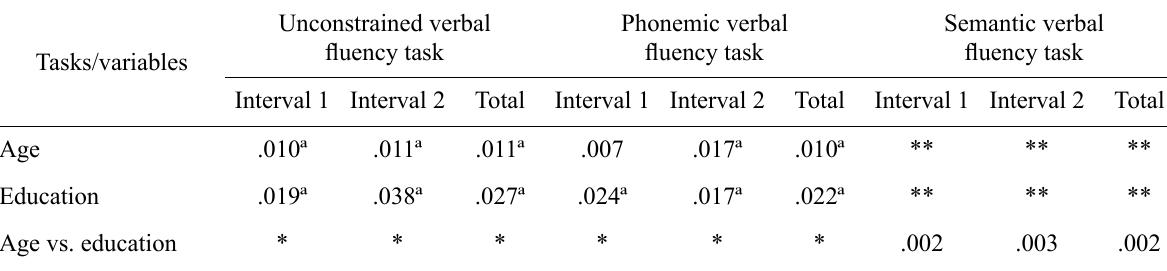
Effect Size ( η ²) of Signi fi cant Main Effects (age and education) and Interaction